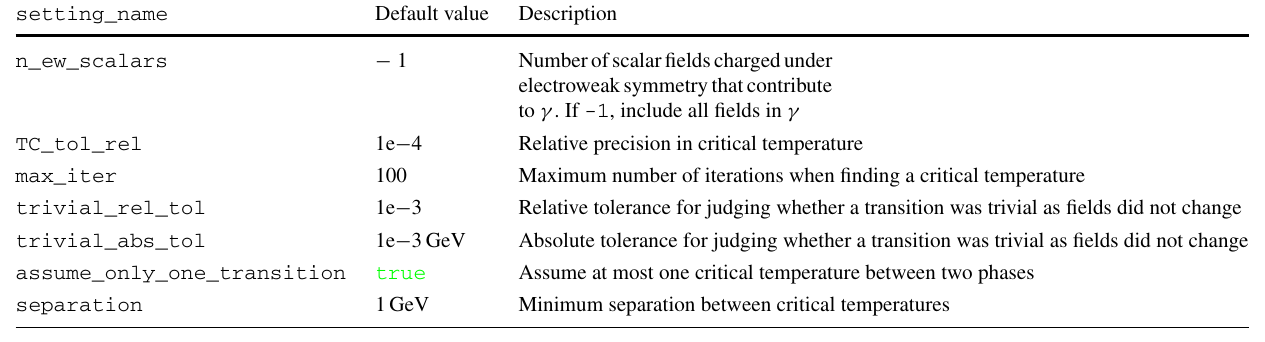
Table 2 Adjustable settings that control the behavior of TransitionFinder object